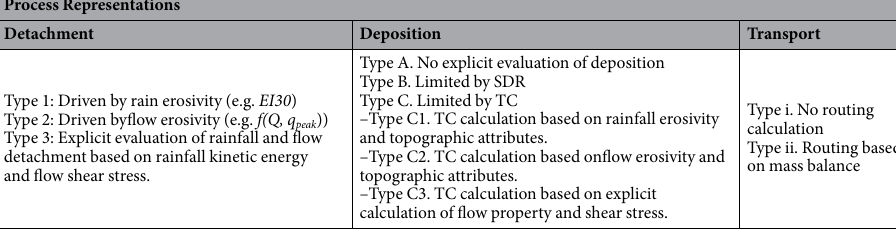
Table 1. A broad classification of detachment, deposition and transport processes in sediment